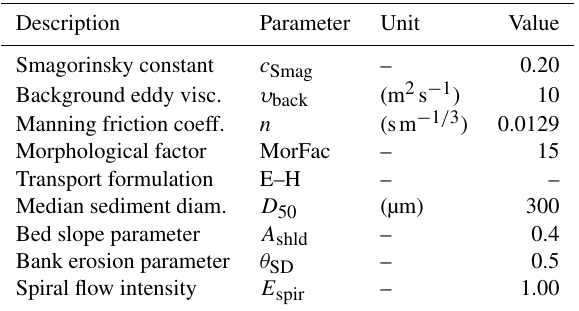
Table 1. Input model parameters.